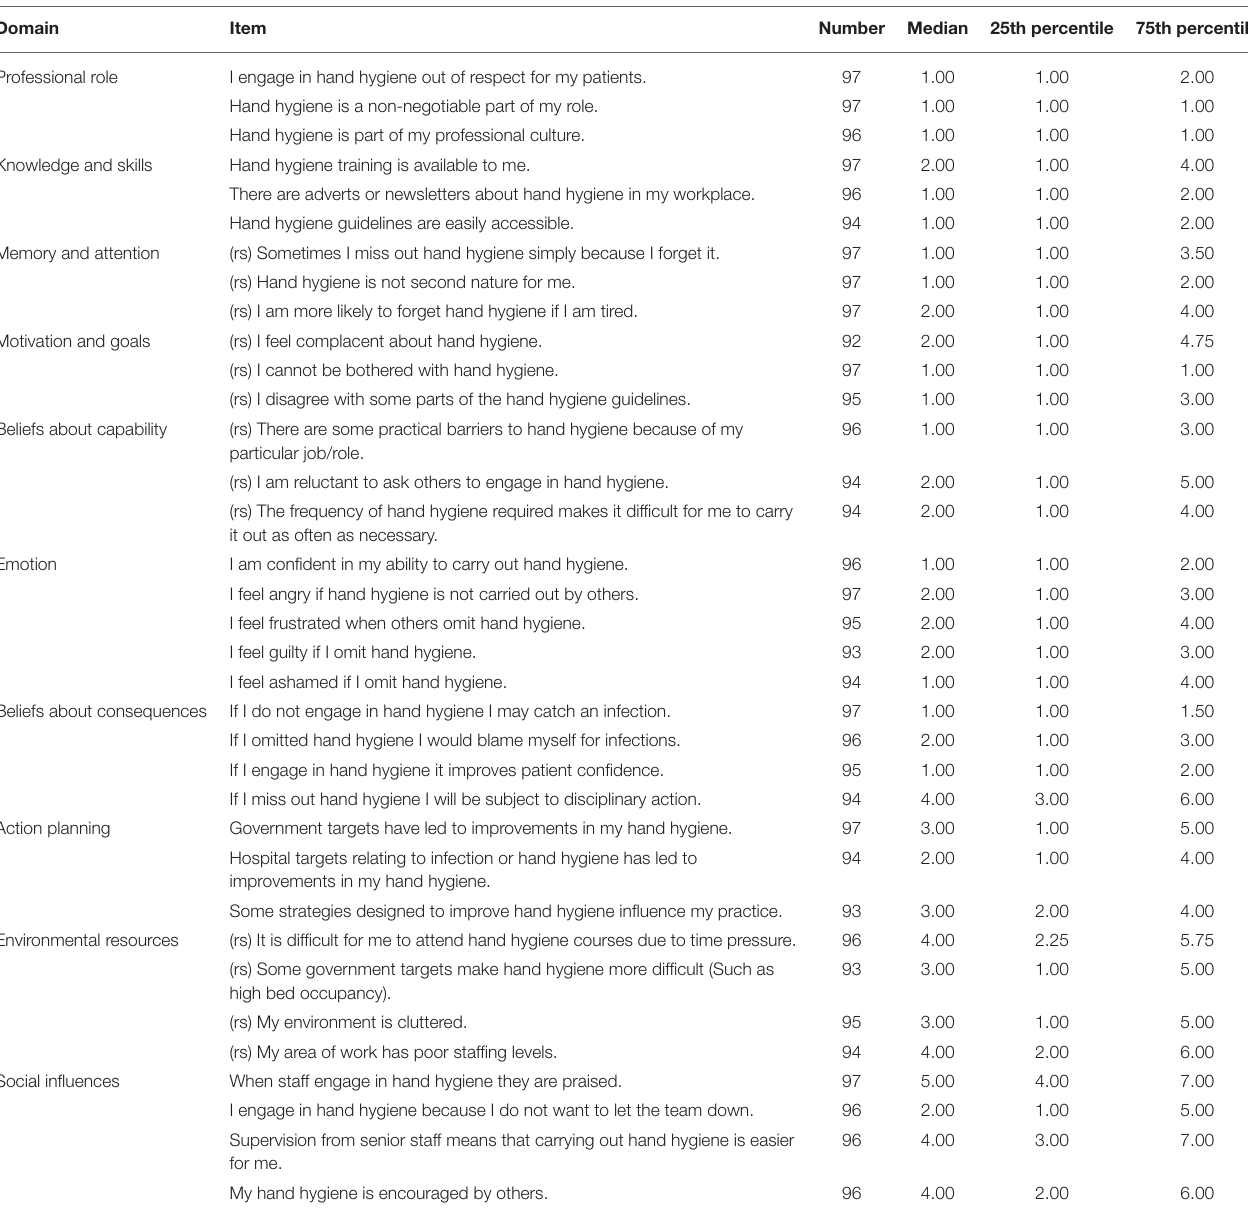
TABLE 6 | Median responses to each item surrounded by its interquartile range.